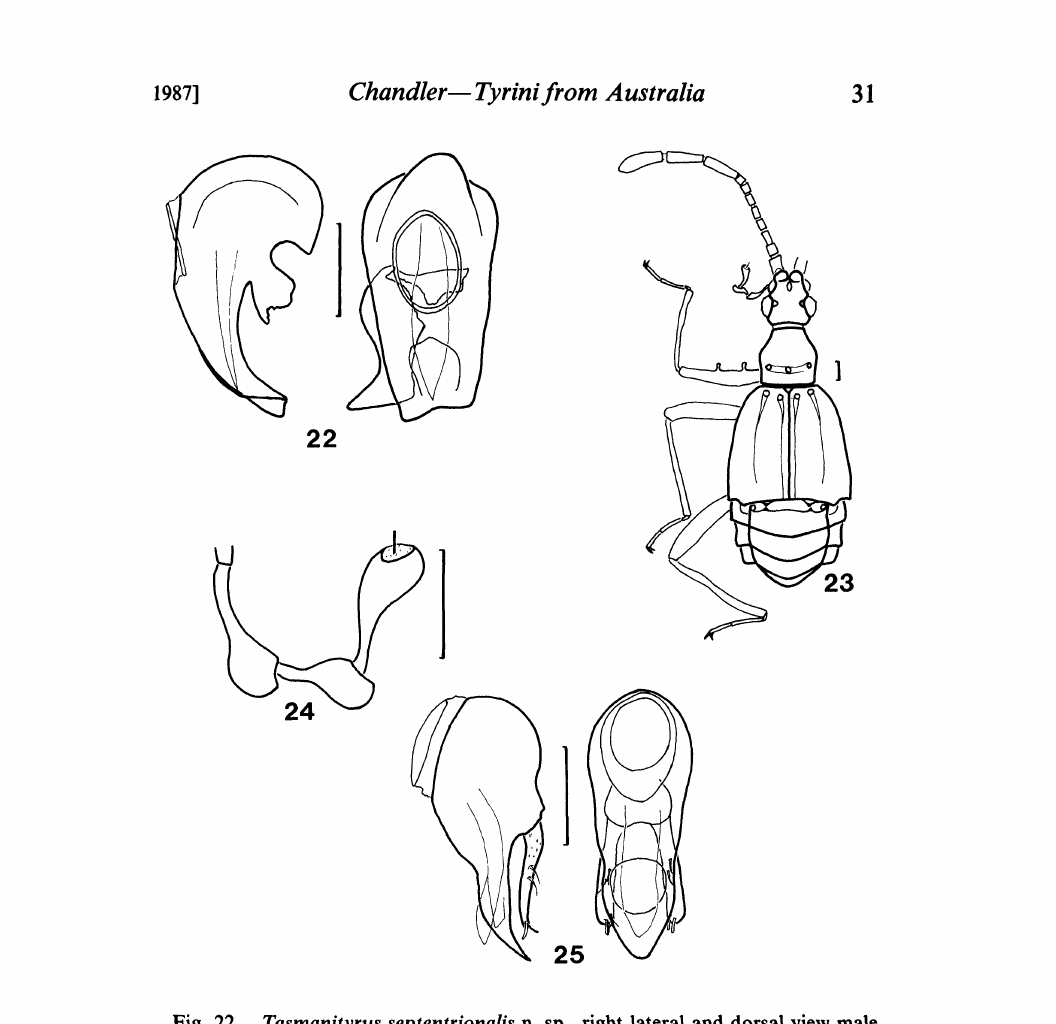
Fig. 22. Tasmanityrus septentrionalis n. sp., right lateral and dorsal view male genitalia, paramere detached. Fig. 23-25. Chasoke victoriae n. sp. 23. Dorsal habitus; 24. dorsal view right maxillary palpus; 25. right lateral and dorsal view male